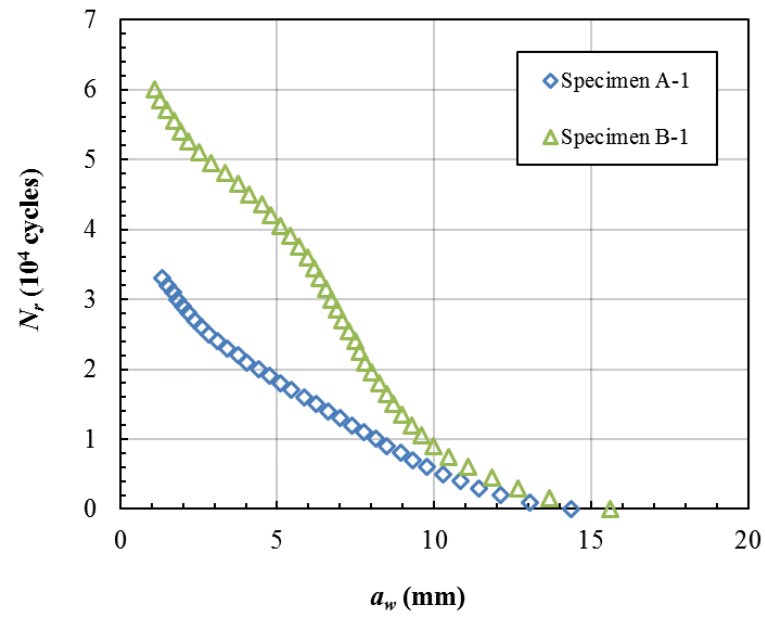
Figure 18. Crack length a w vs residual cycles N r of specimens.